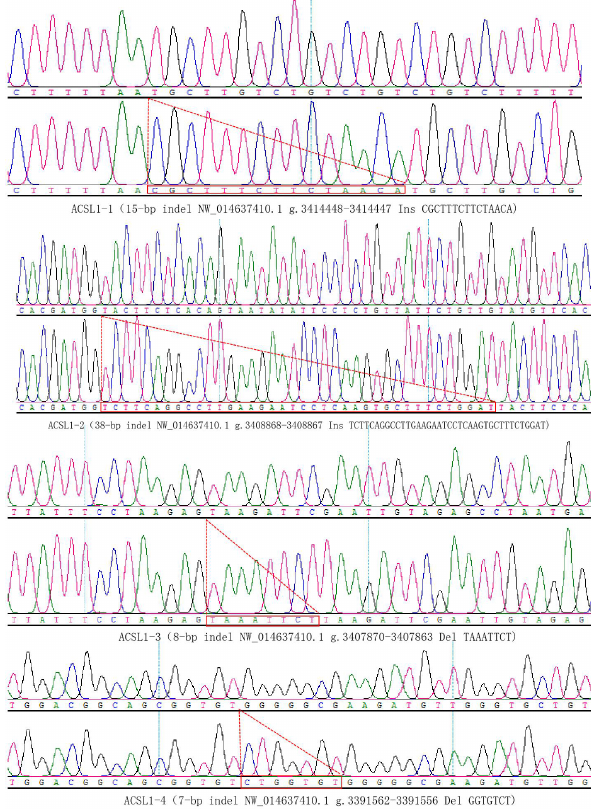
Figure 4. Sequencing validation of four mutation sites of the ACSL1